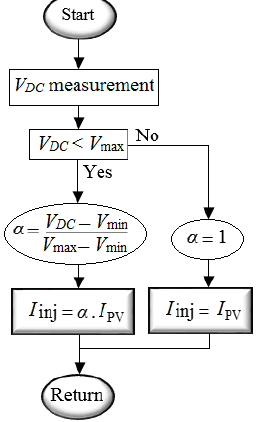
Figure 10. Proposed controller to regulate the DC-link voltage.